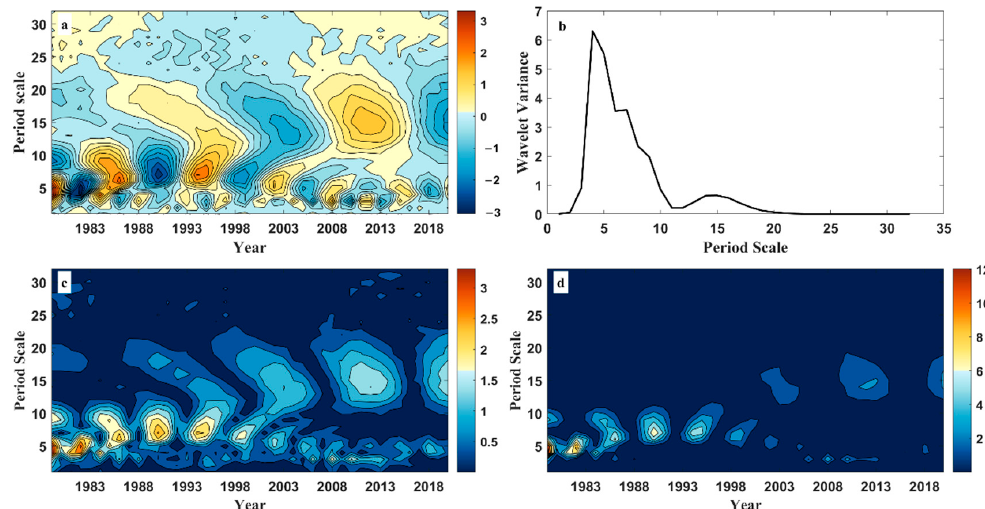
Figure 3. Wavelet analysis results of the occurrence frequency of Ural Mountains blocking high in extended winter (( a ): real part of wavelet coefficient; ( b ): wavelet variance; ( c ): modulus of wavelet coefficient; ( d ): modulus square of wavelet coefficient).